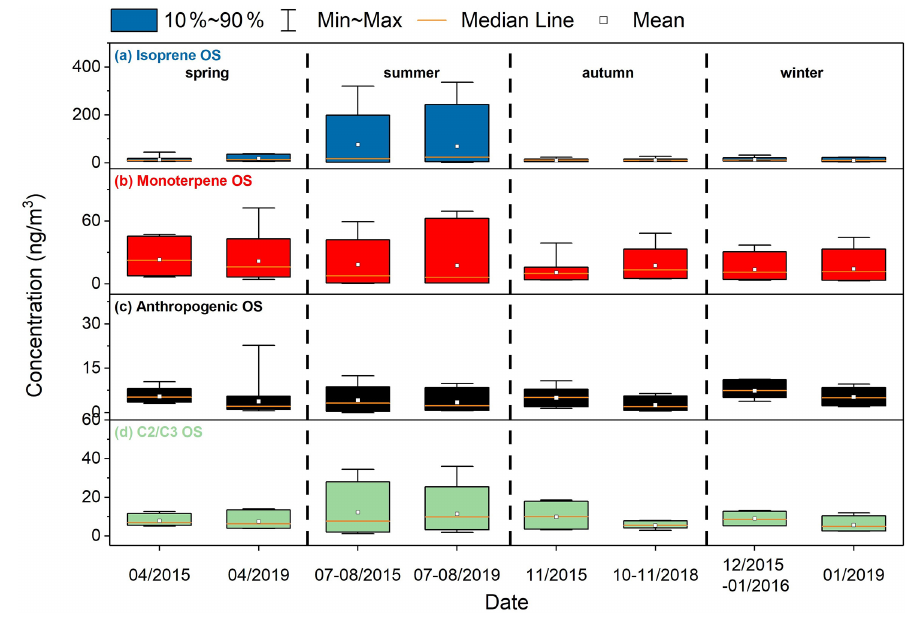
Figure 4. Concentrations of different types of the quantified OSs over the four seasons in 2015–2016 and